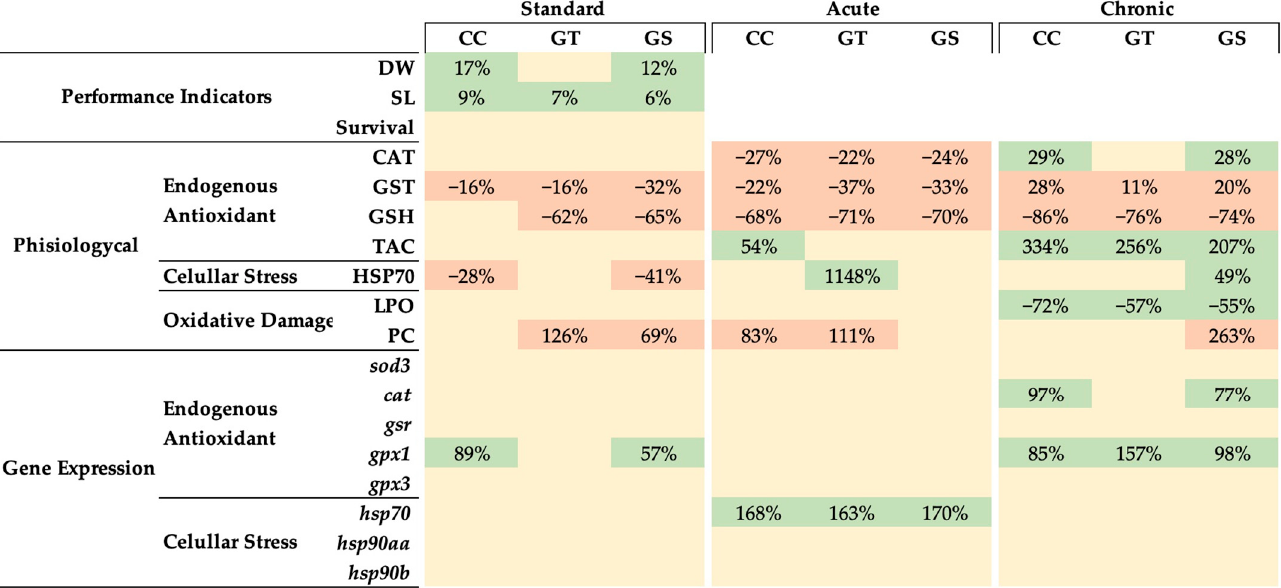
Figure 5. Integrative analysis of performance indicators, physiological and gene expression biomarkers of oxidative status in Senegalese sole postlarvae fed antioxidant-supplemented diets (CC, GT, and GS) during the experimental period (standard, acute, and chronic). All the data were normalized to the CTRL fish responses at standard condition (([test diet value]/[CTRL diet value] − 1) × 100). Percentages given correspond to inferior (orange color) and superior (green color) values of the different dietary treatments in relation to CTRL fish at standard condition ( p < 0.05, 1-way ANOVA).